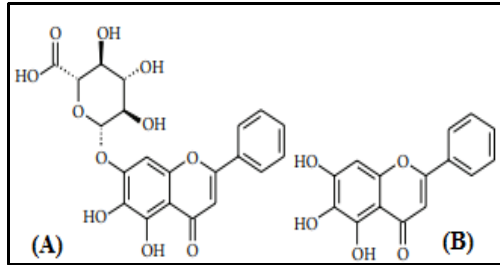
Figure 3. Chemical structure of (A) biacalin and (B) biacalein (56)